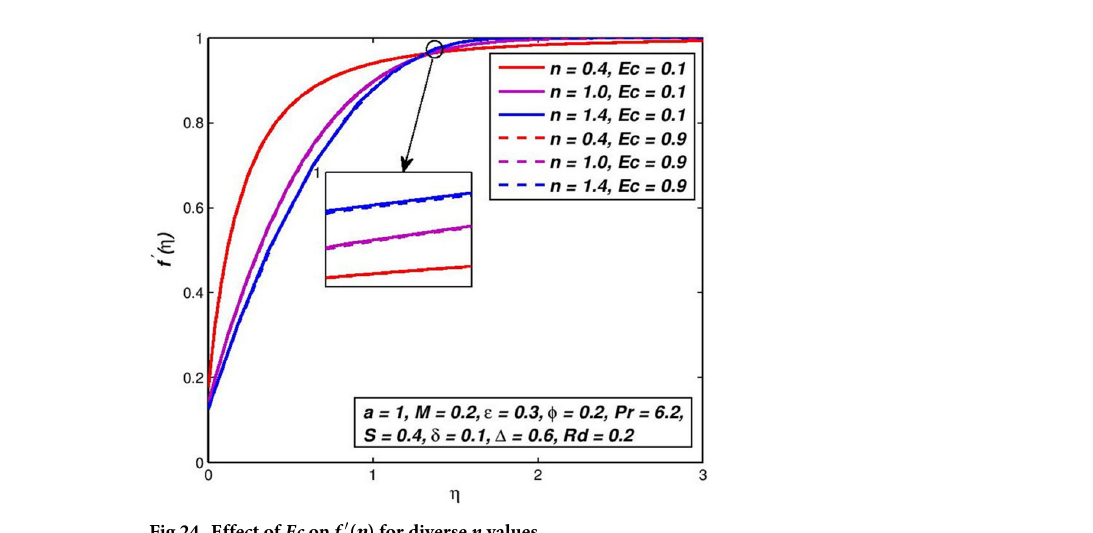
Fig 24. Effect of Ec on f 0 ( η ) for diverse n values.